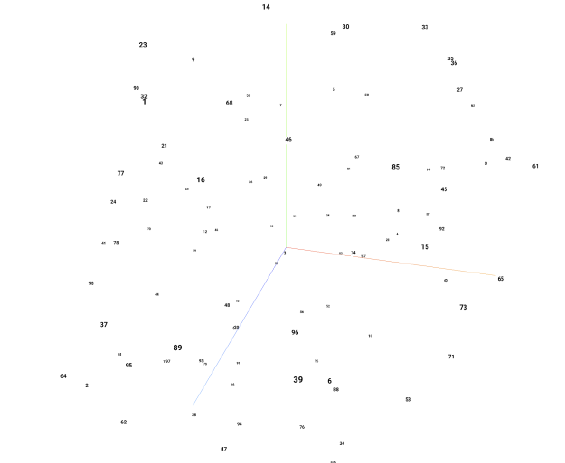
Figure 9. The demonstration of the UMAP 25 neighbors’ result.